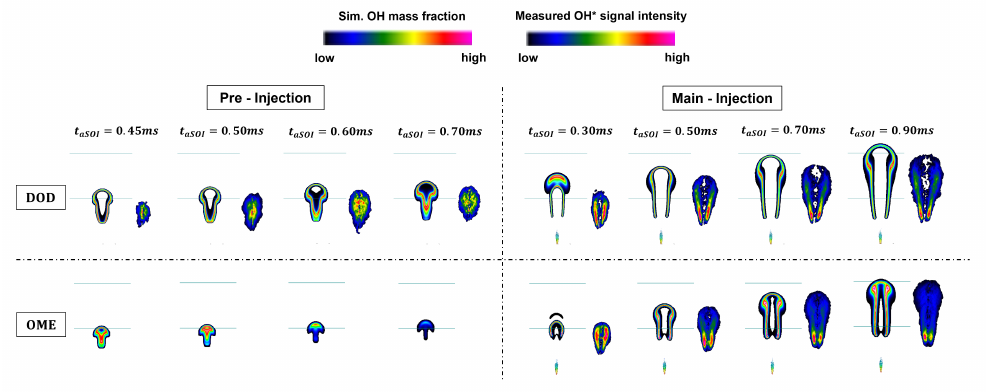
Figure 16. Conti3L ( ArM ): OH flame shape for multi-injection: Simulation vs experiment. ( top ) Do- decane. ( bottom )